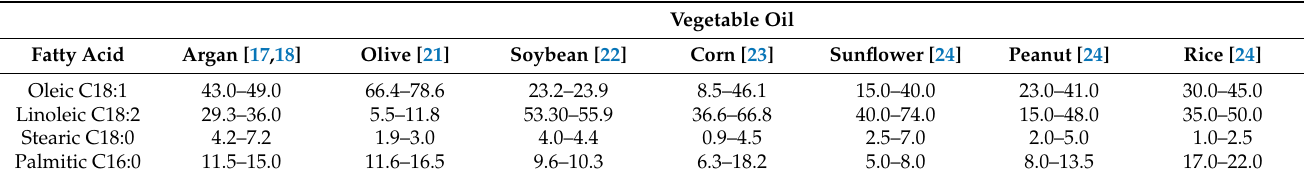
Table 1. Percentages of total fatty acids in Argan oil and other vegetable oils. Vegetable